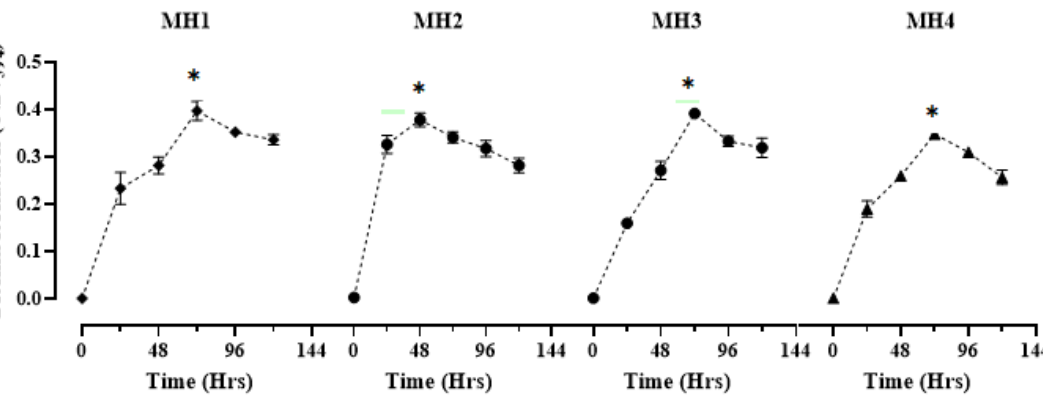
Figure 1. Biofilm time kinetics of MH1, MH2, MH3, and MH4 (Table 2). Bacterial strains were incubated for 0, 24, 48, 72, 96, and 120 h. Biofilm formation was examined using crystal violet (CV) staining method. Values represent mean + SD ( n = 3) at significance level ( p < 0.05). * and green line indicate the significantly highest biofilm formation with different time kinetics for various bacterial isolates. Table 3. Biofilm formation time kinetics by different bacterial isolates and combinations at various time